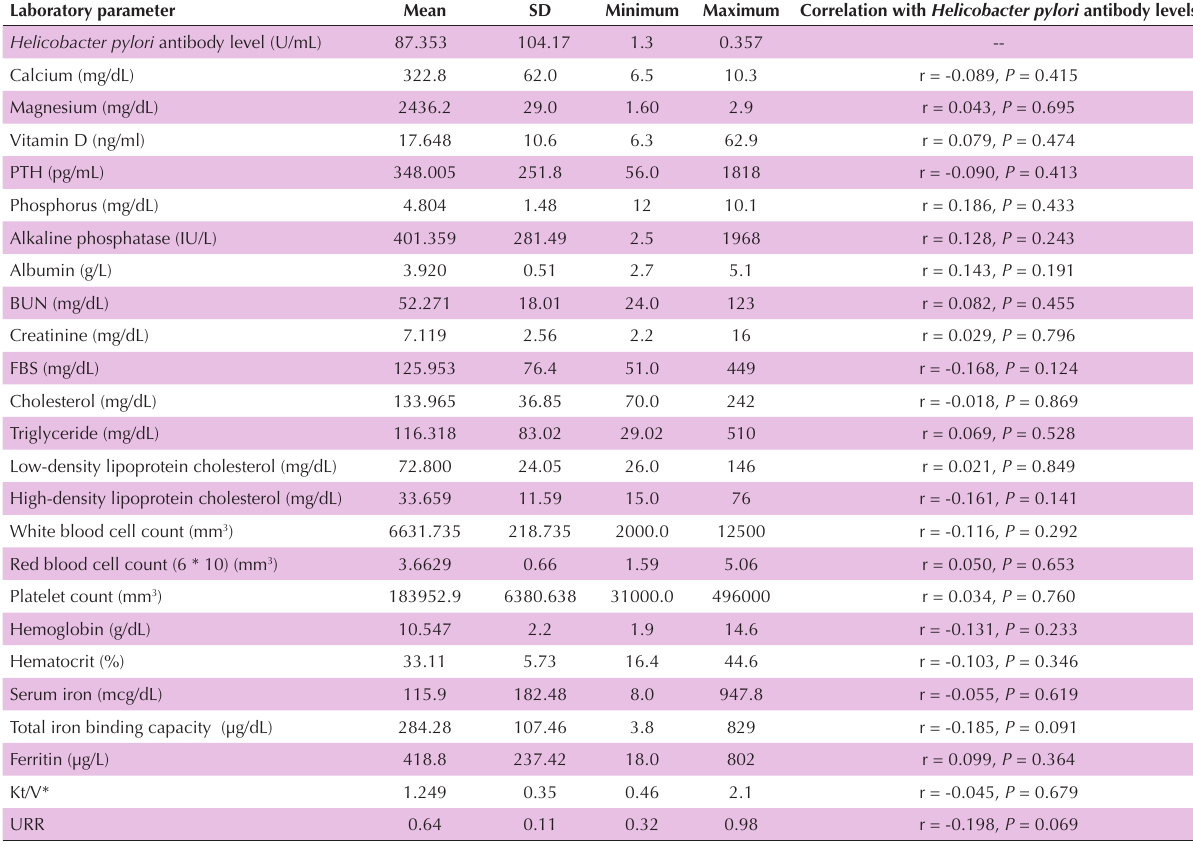
Table 2. Mean, standard deviation, minimum and maximum level of laboratory parameters in patients and its relationship with Helicobacter pylori antibody level Laboratory parameter Mean SD Minimum Maximum Correlation with Helicobacter pylori antibody levels